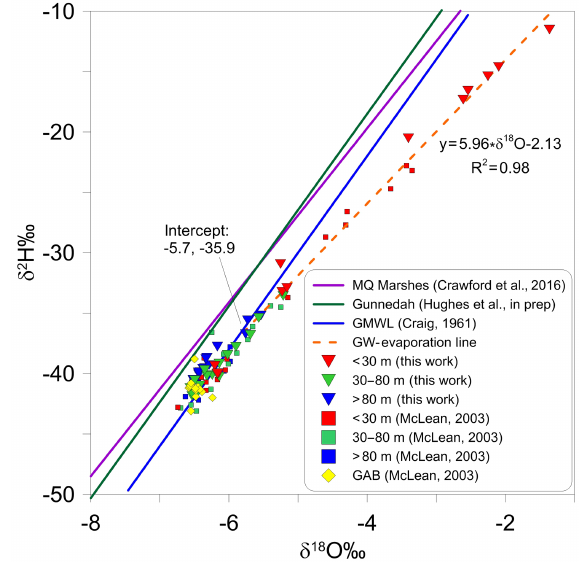
Figure 4. Water stable isotopes in the LNA, showing the two sepa- rate mechanisms of recharge; surface water recharge plotting along an evaporation trend line and potential inflow from the GAB clus- tered with regional samples from the GAB (McLean, 2003).